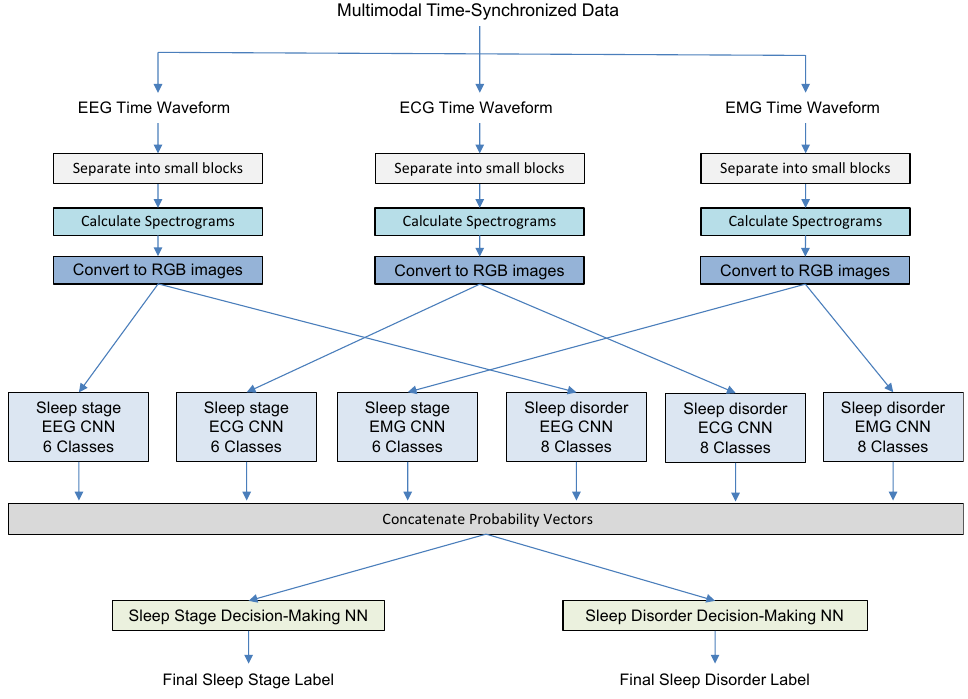
Figure 3. Experiment 3: Sleep stage and sleep disorder classification using